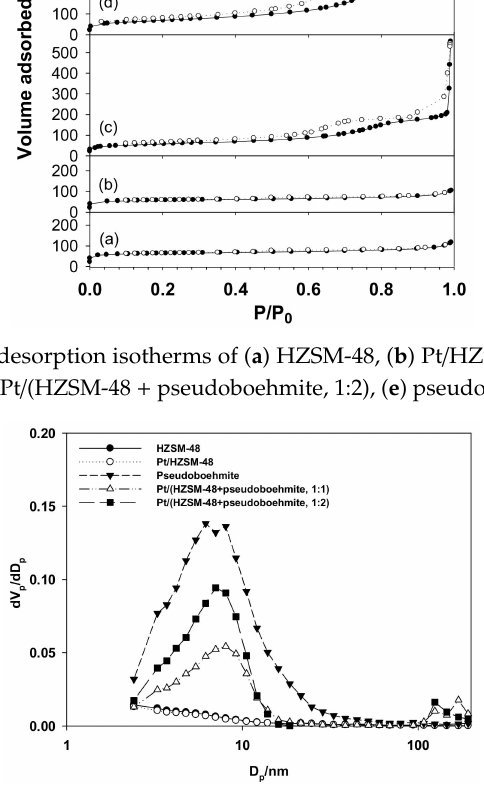
Figure 5. Pore size distribution of various